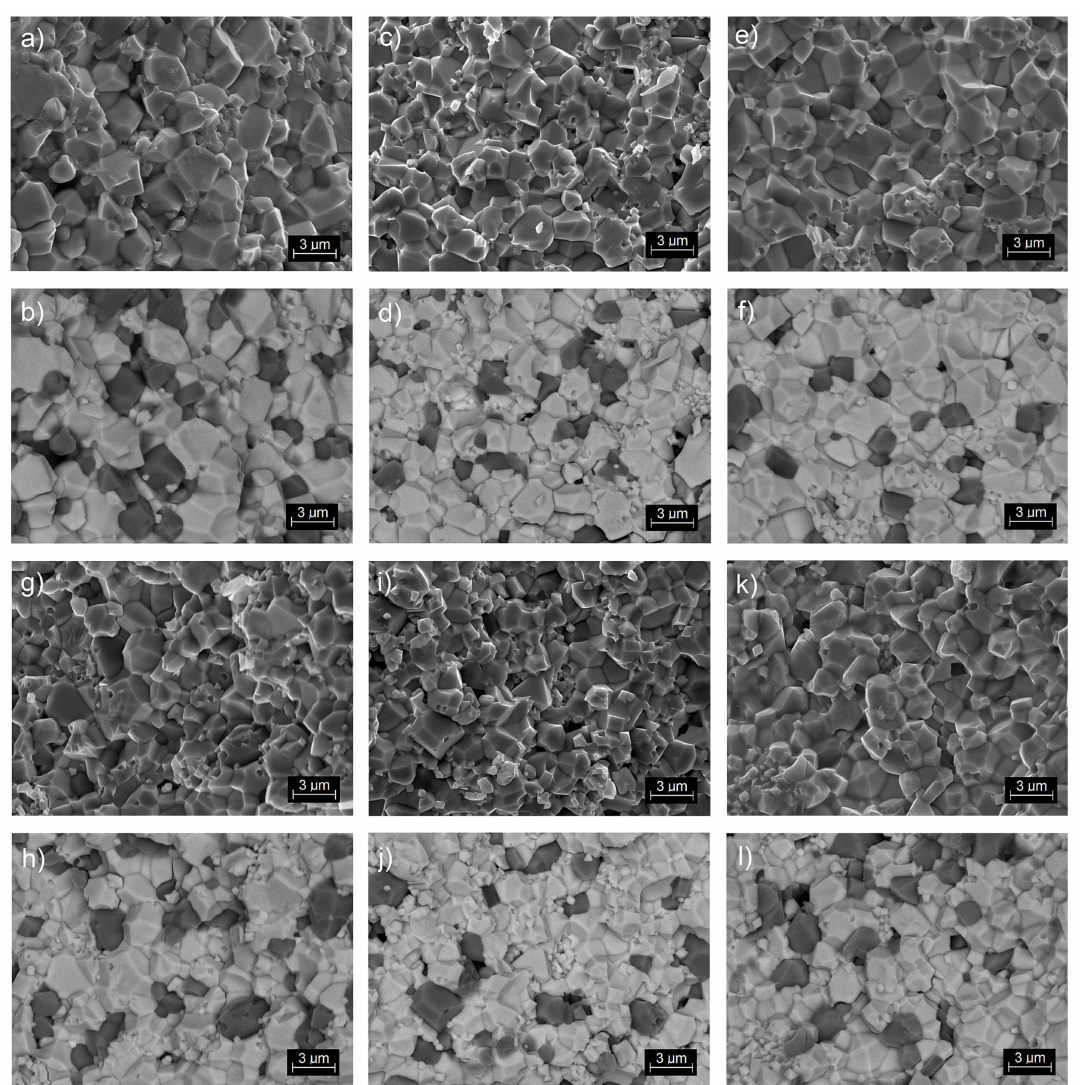
Figure 3. SEM microstructure of PP-F samples: ( a , b ) PP25-F, ( c , d ) PP28-F, ( e , f ) PP31-F, ( g , h ) PP34-F, ( i , j ) PP37-F, ( k , l ) PP40-F. The images were taken in the standard SB mode (detection of the assembly of signals from the secondary and backscattered electron detectors—Figure 3a,c,e,g,i,j) and BSE (detection of backscattered electrons—Figure